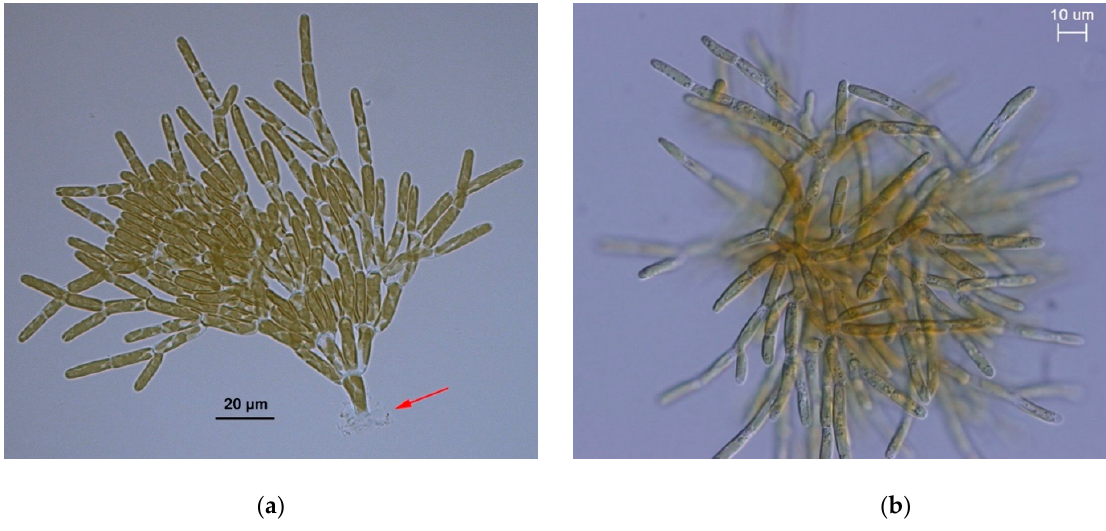
Figure 3. Schizocladia ischiensis from laboratory culture. ( a ) New strain RH15-53 from Rhodes, removed from Petri dish bottom. Original attachment was by amorphous extracellular material (arrow) secreted at lower end of wedge-shaped basal cell ( b ) Strain KU-333 from Ischia. Note similar dimensions and overall cell morphologies.